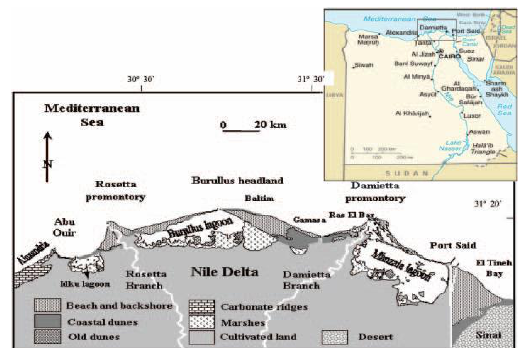
Figure.1 The Burullus Region